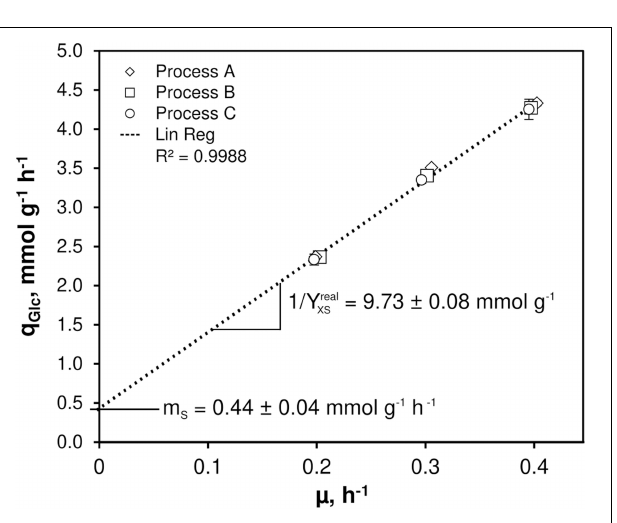
FIGURE 2 | Determination of non-growth rate associated maintenance parameter (m S ) and growth rate associated maintenance parameter (1/Y real , xGLC ) for C. glutamicum WT. Growth rates ( µ ) and corresponding glucose consumption rates (q GLC ) derived from three individual continuous chemostat processes (A, B, C) built the basis for the linear regression revealing m S and 1/Y real , xGLC as indicated. The strain was cultivated in CGXII minimal medium supplemented with 30 mg PCA L - 1 and 12 g D -glucose L - 1 as carbon source. Mean values ± standard deviations were calculated from three technical replicates per growth rate installed in each